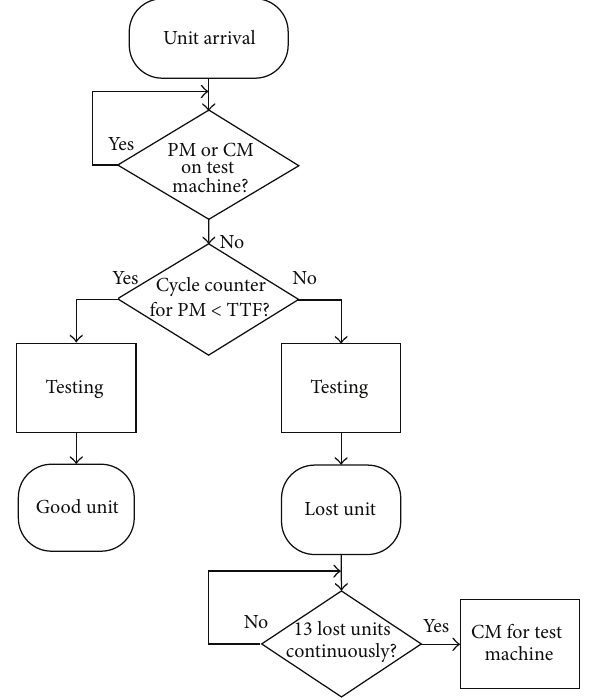
Figure 3: Flowchart of RCM model of the test machine.